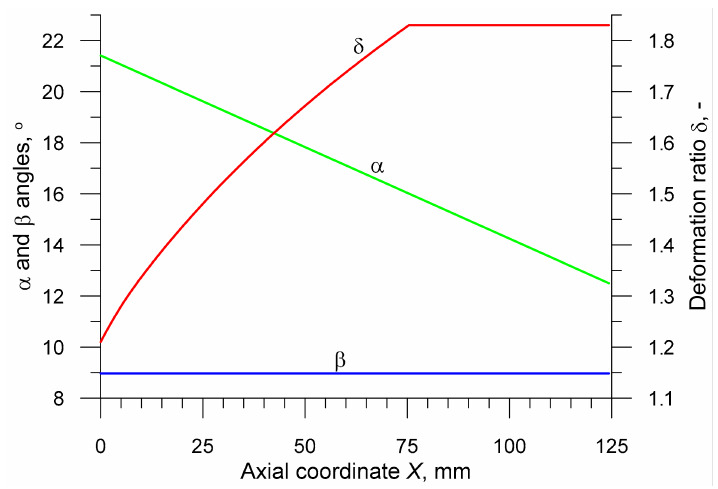
Figure 2. Parameters describing the formation of a specimen in the CWR test versus axial coordinate X .